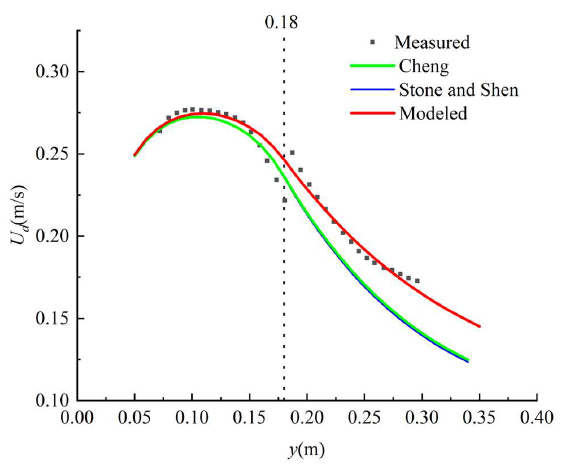
Figure 3. The water depth-averaged streamwise velocity between the experimental data and analyti- cal solution in case 2. ϕ 1 = 0.6522, ϕ 2 = 0.662, and ϕ 3 = 0.4681.